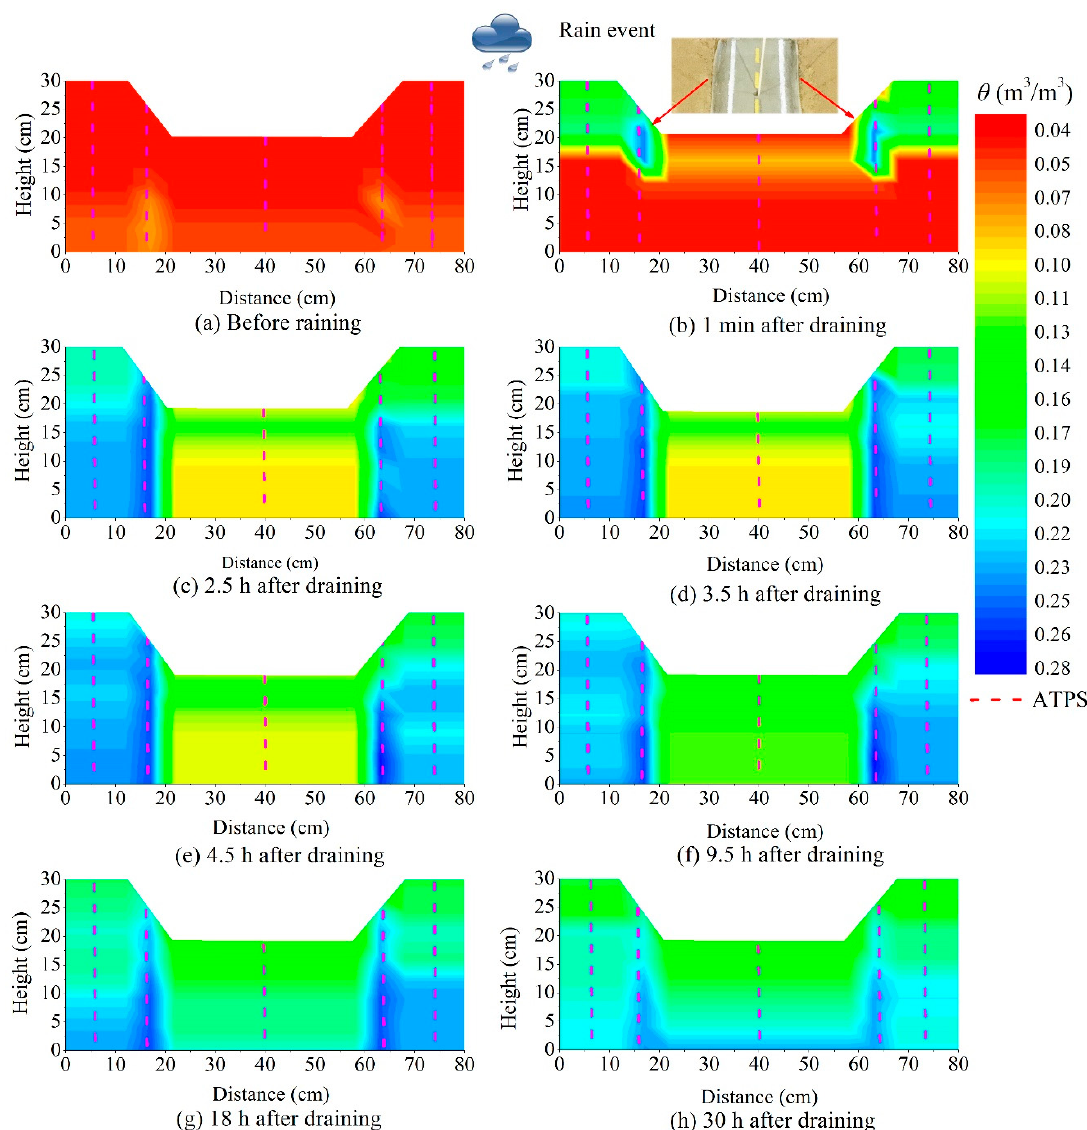
Figure 8. Soil moisture content (color) on the subgrade and slope after rainfall during the NM test.